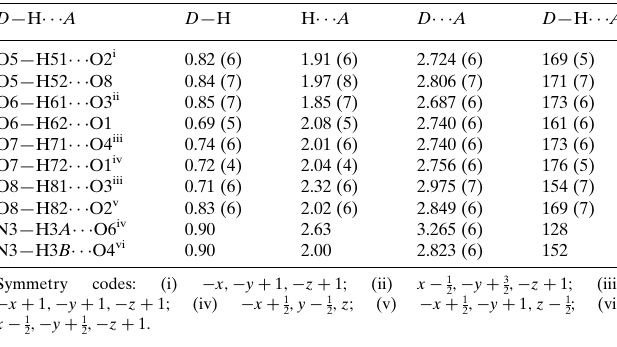
Hydrogen-bond geometry (A˚ , (cid:3)